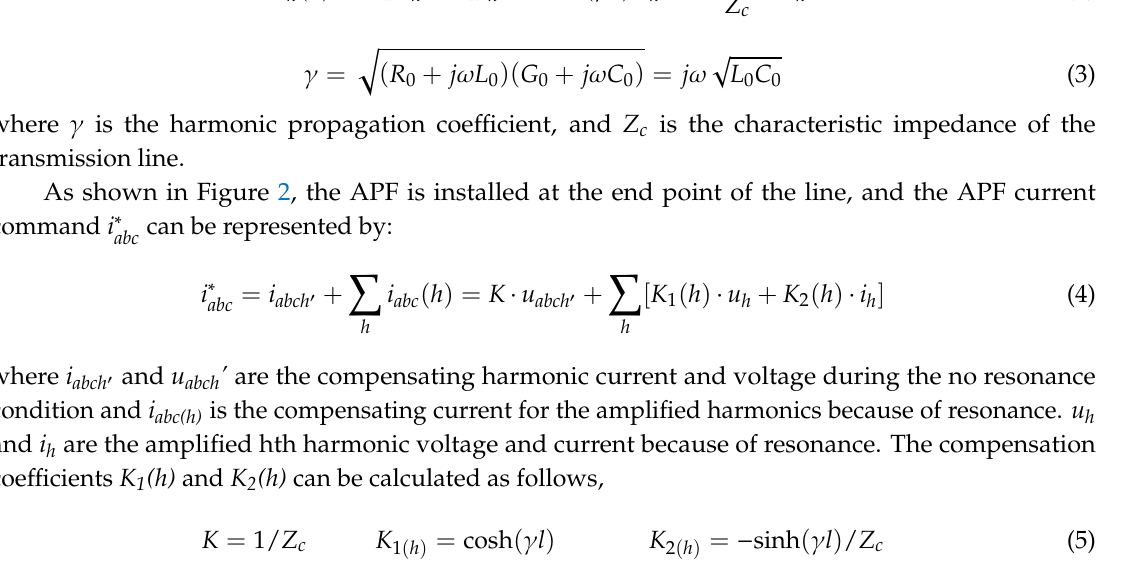
Figure 3. i p -i q calculation.